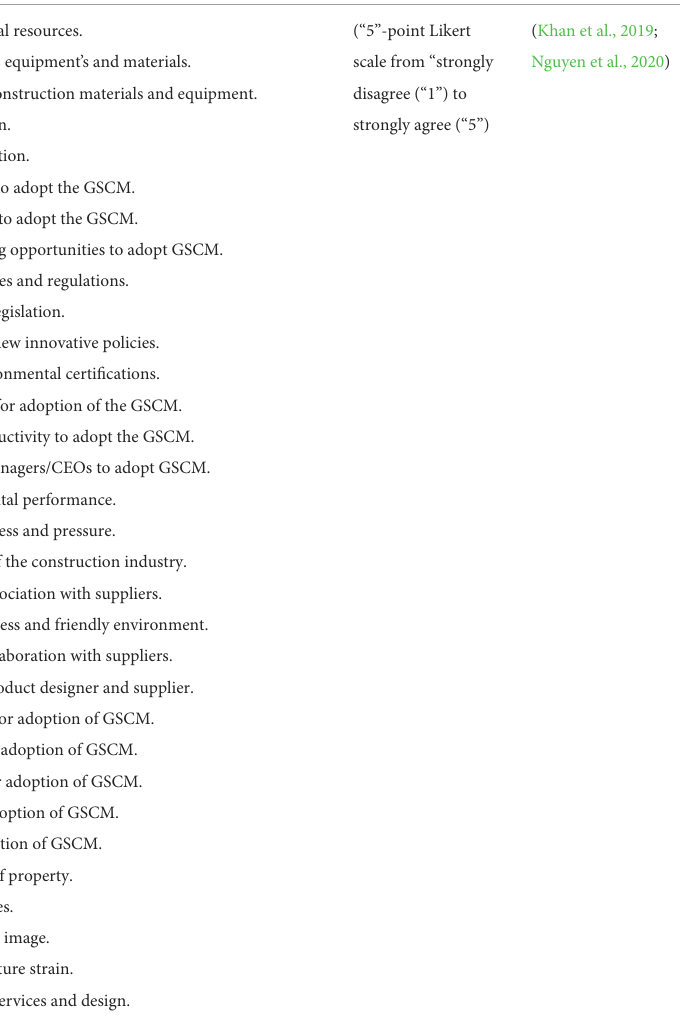
TABLE 3 Construct and measurements item. Construct Measurements